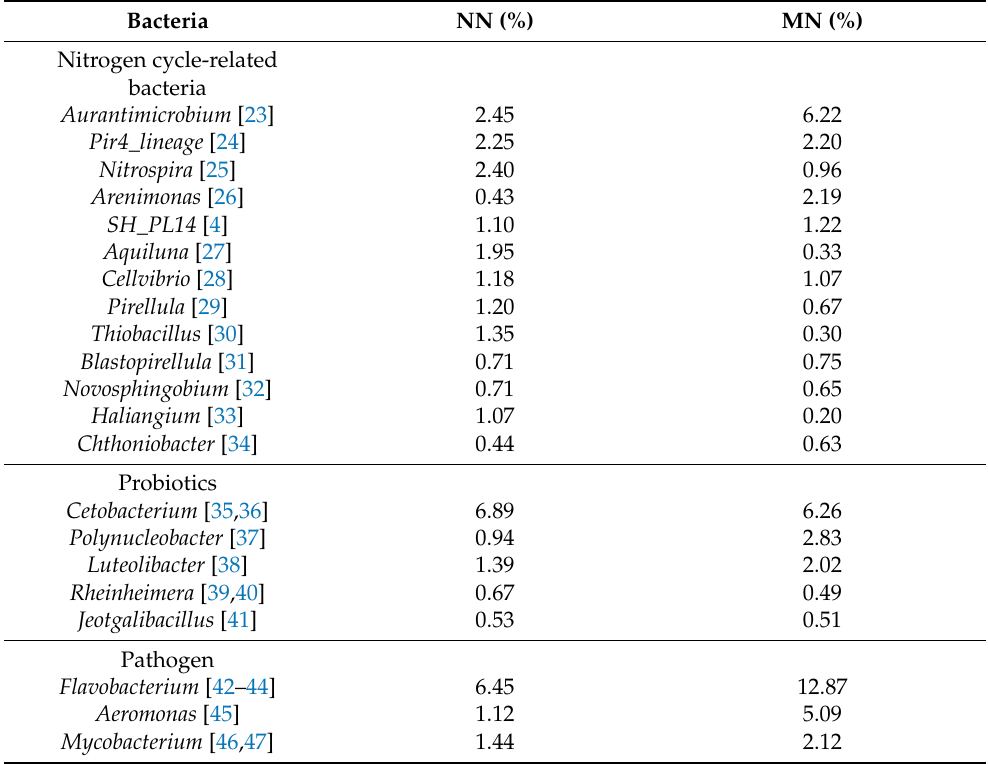
Table 4. Primary bacterial composition in the experimental aquaponic system. OTU analysis based on the genus level. Bacteria NN (%) MN (%) Nitrogen cycle-related bacteria Aurantimicrobium